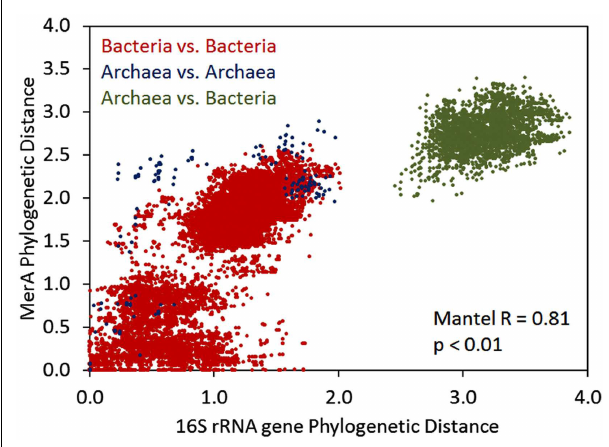
FIGURE 3 | Mantel regression of a matrix describing Rao’s phylogenetic distance among MerA proteins and a matrix describing Rao’s phylogenetic distance among 16S rRNA genes in all chromosomally encoded merA . Color overlays indicate the pairwise comparisons that are being